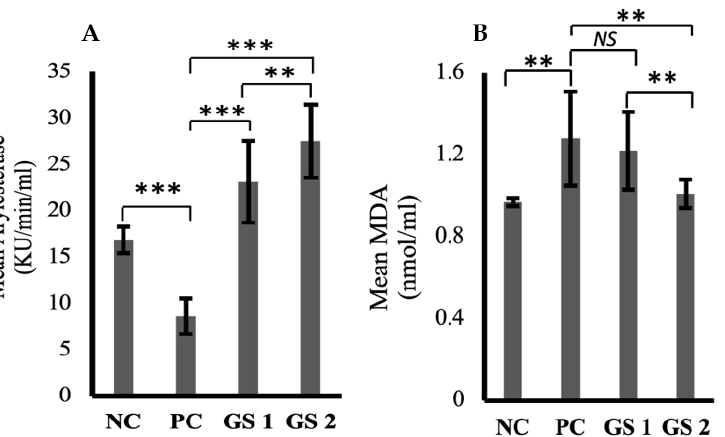
Figure 3. Mean values of arylesterase (Ku/min/mL) ( A ) and melanodialdehyde (MDA, nmol/mL) ( B ) activity in different treatment groups. Negative control (NC), Positive control (PC), Gymnema sylvestre 250mg (GS1), Gymnema sylvestre 500mg (GS2). NS : non-significant , ( ** ): p ≥ 0.01, ( *** ): p ≥ 0.001.